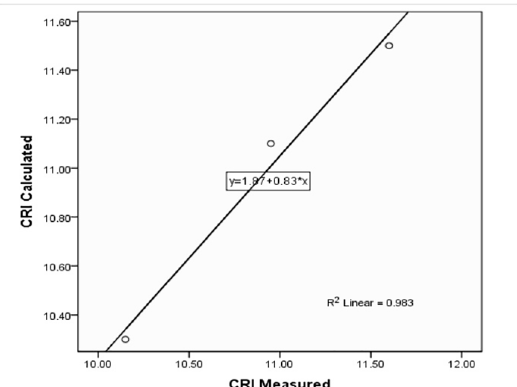
Figure 12. CRI vs. CRI Measured